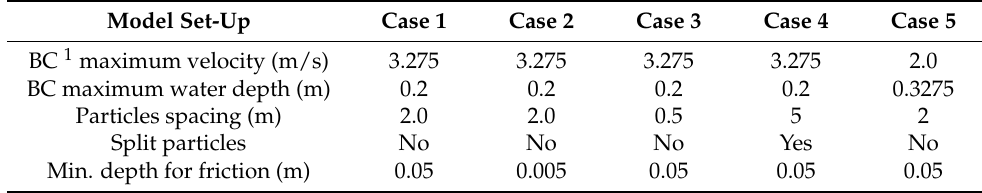
Table 3. Momentum conservation test